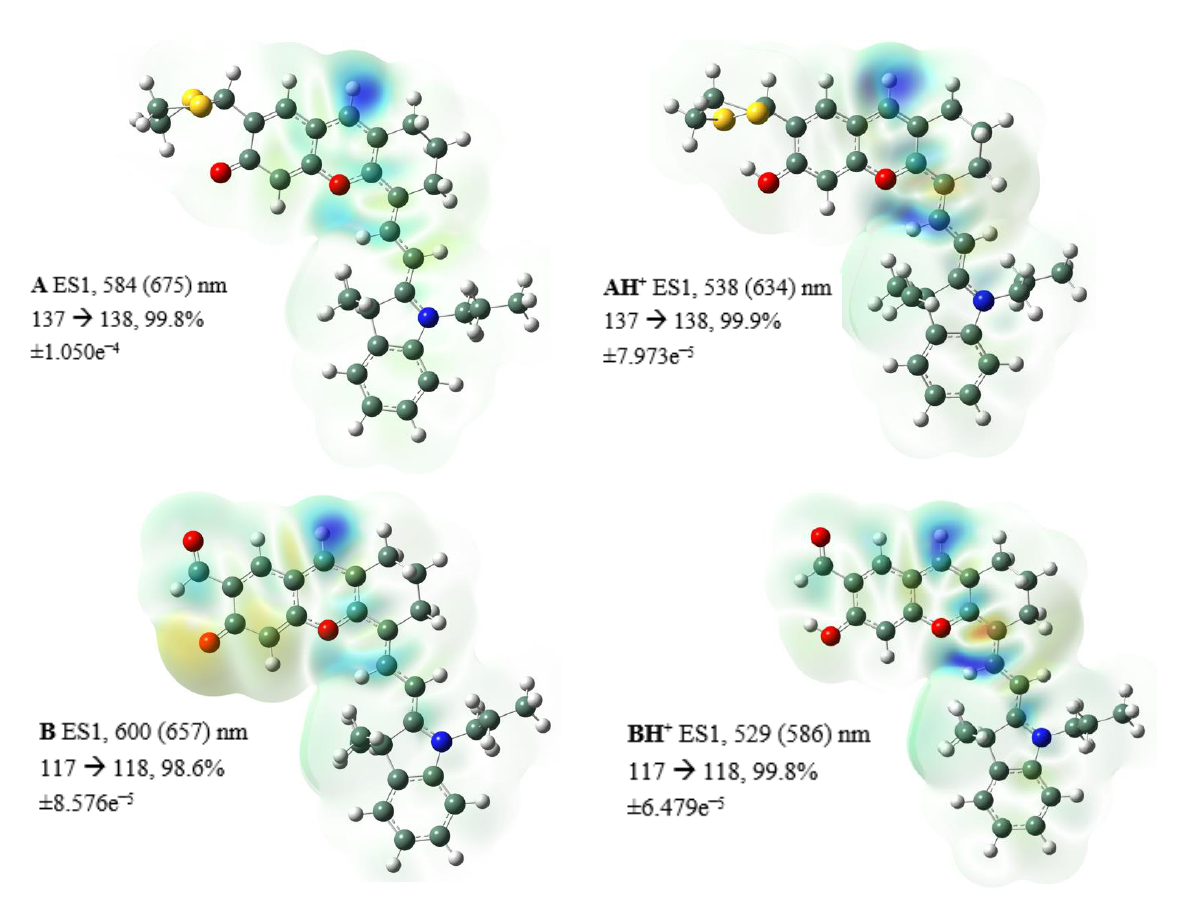
Figure 6. Illustrations of the current density difference as isosurfaces of the probes A and B and their protonated forms, AH + and BH + , as indicated for the excited states (ES) and the calculated (and experimental) wavelengths. The composition of specific ES and percentage contributions are indicated. The numerical range values for the color scale are also listed for each drawing. Drawings of the numbered MOs are available in the Supporting Information.